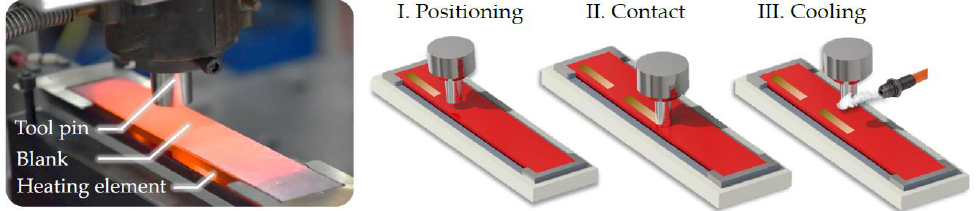
Figure 2. Testing apparatus and experimental procedure for quantifying the wear and friction behavior of unmodified and laser-implanted tool surfaces.